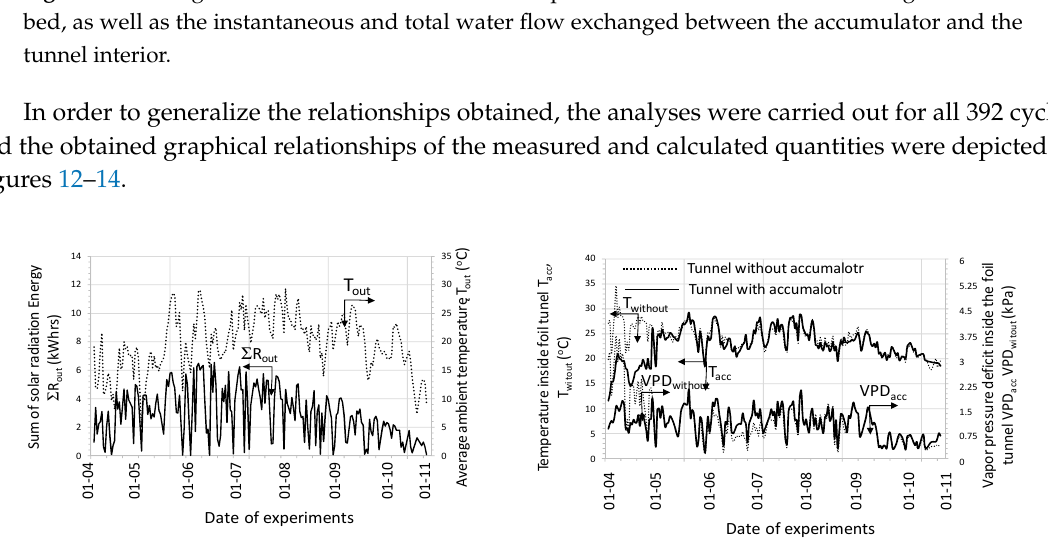
Figure 12. Averaged course of measured parameters during accumulator charging cycles.